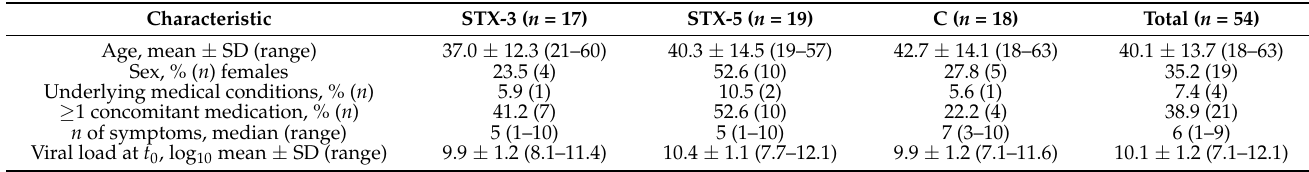
Table 1. Sociodemographic and clinical characteristics of